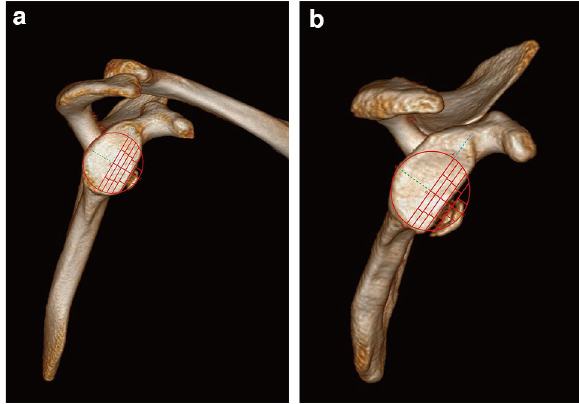
Figure 7. ( a , b ) Superimpose the comparison card with the en face view of